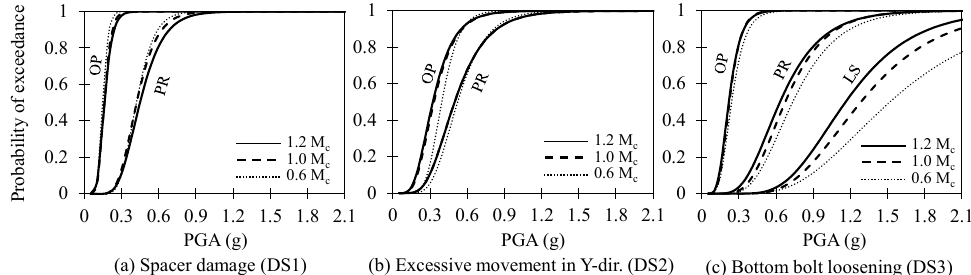
fragility curves derived from the values of the median and the standard deviation presented in Table 7.